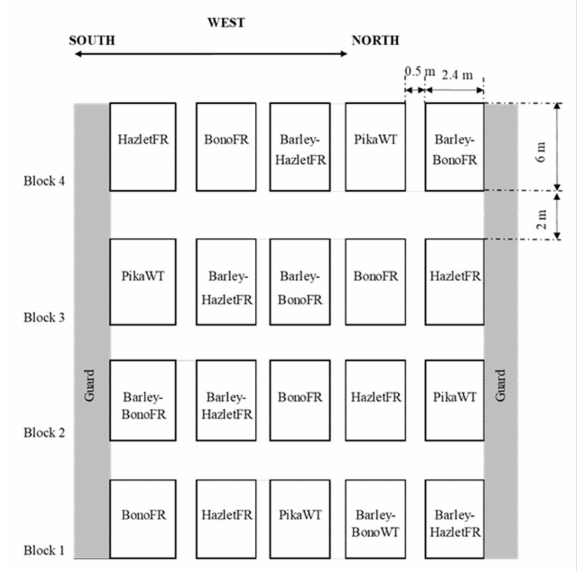
Figure 1. Experimental field layout of trial. Note: BonoFR, fall rye cv. Bono; HazletFR, fall rye cv. Hazlet; PikaWT, winter triticale cv. Pika; Barley-BonoFR, double cropping treatment of spring barley (cv. Maverick) followed by BonoFR; Barley-HazletFR, double cropping treatment of spring barley followed by